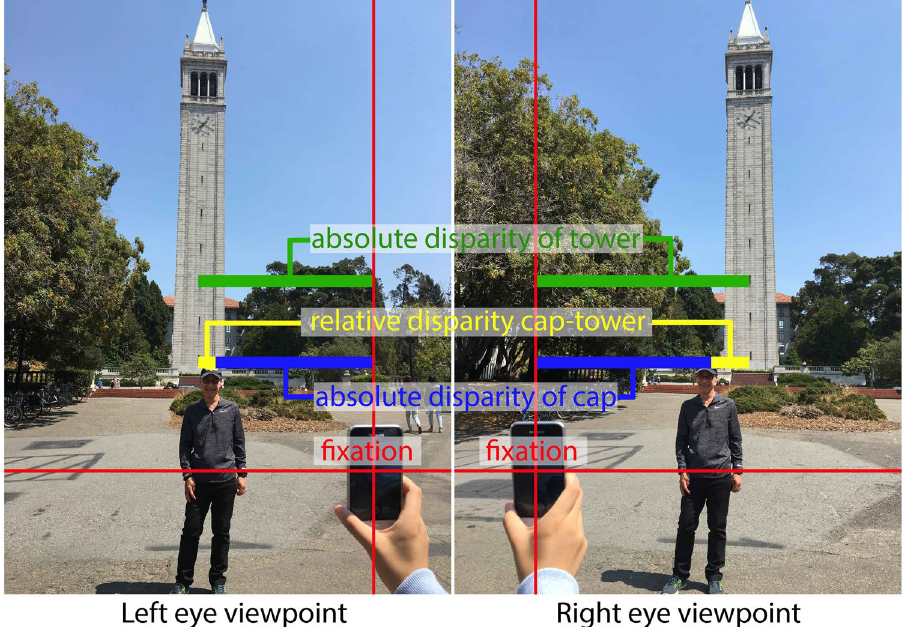
Figure 1. Schematic illustration of absolute and relative disparities. Left and right panels show the viewpoints from left and right eyes respectively. The observer fixates on the phone (fixation indicated in red crosshairs). The absolute disparity of the author’s cap is the sum of the distances indicated in blue while the absolute disparity of the tower (Berkeley’s campanile) is the sum of the distances indicated in green. The relative disparity between the cap and the tower is the sum of the distances indicated in yellow, and also the differences of the absolute disparities of the cap and of the tower. A more formal definition can be found in ref.